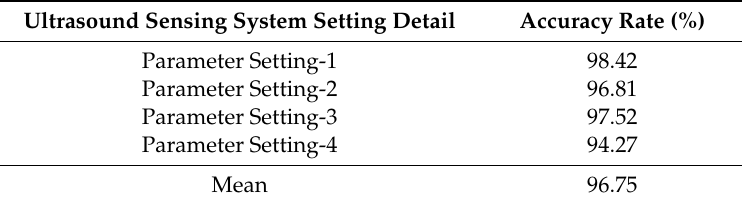
Table 12. Classification results of the SVM-enabled intelligent genetic algorithmic model when it chooses five universal features.